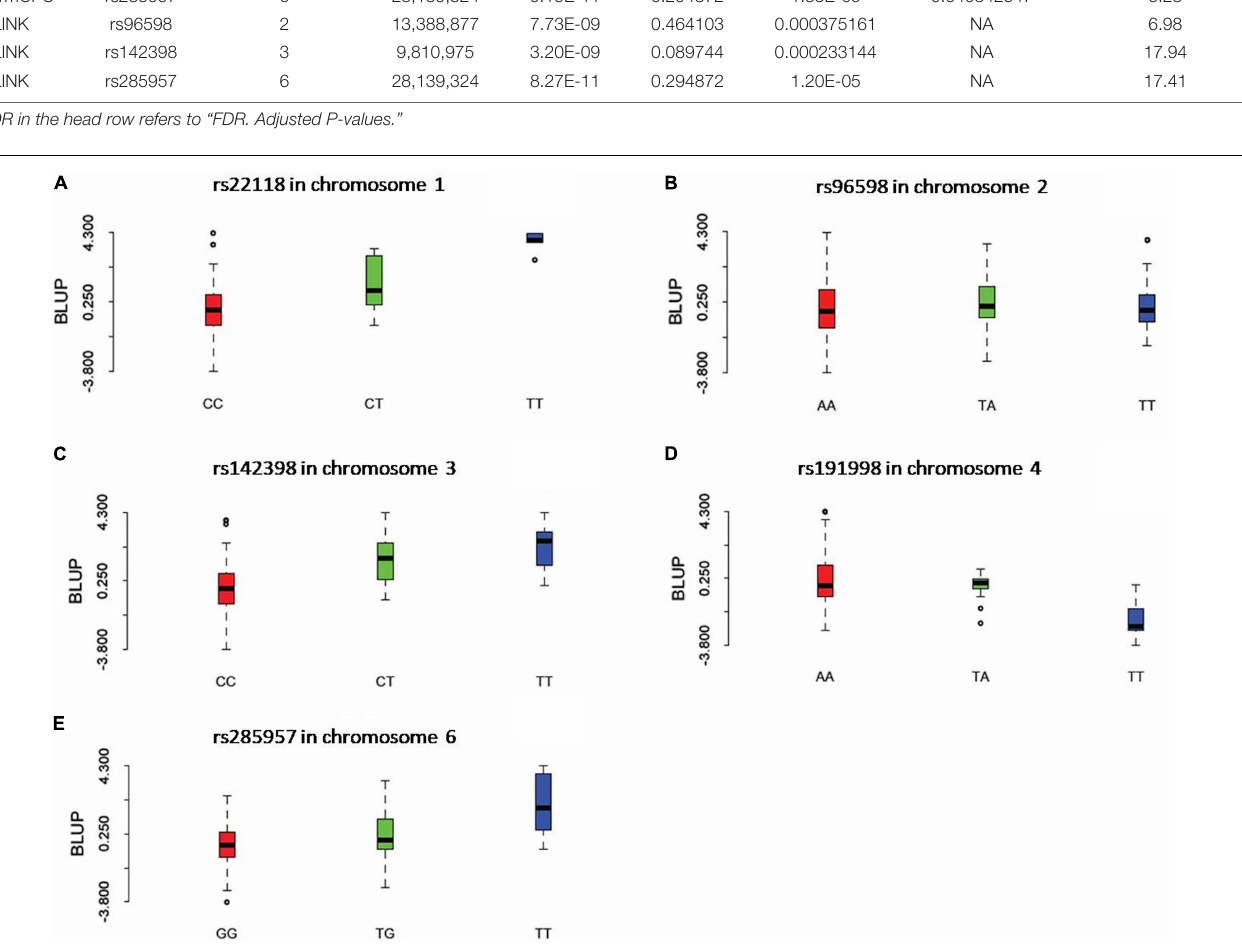
FIGURE 5 | The boxplots show the comparison of the phenotypic performance illustrated by the BLUP value for different genotypes of the five significant SNPs. For each graph, X axis indicates the different genotypes of SNP rs22118 (A) , rs96598 (B) , rs142398 (C) , rs191998 (D) , and rs285957 (E) . Y axis indicates the BLUP